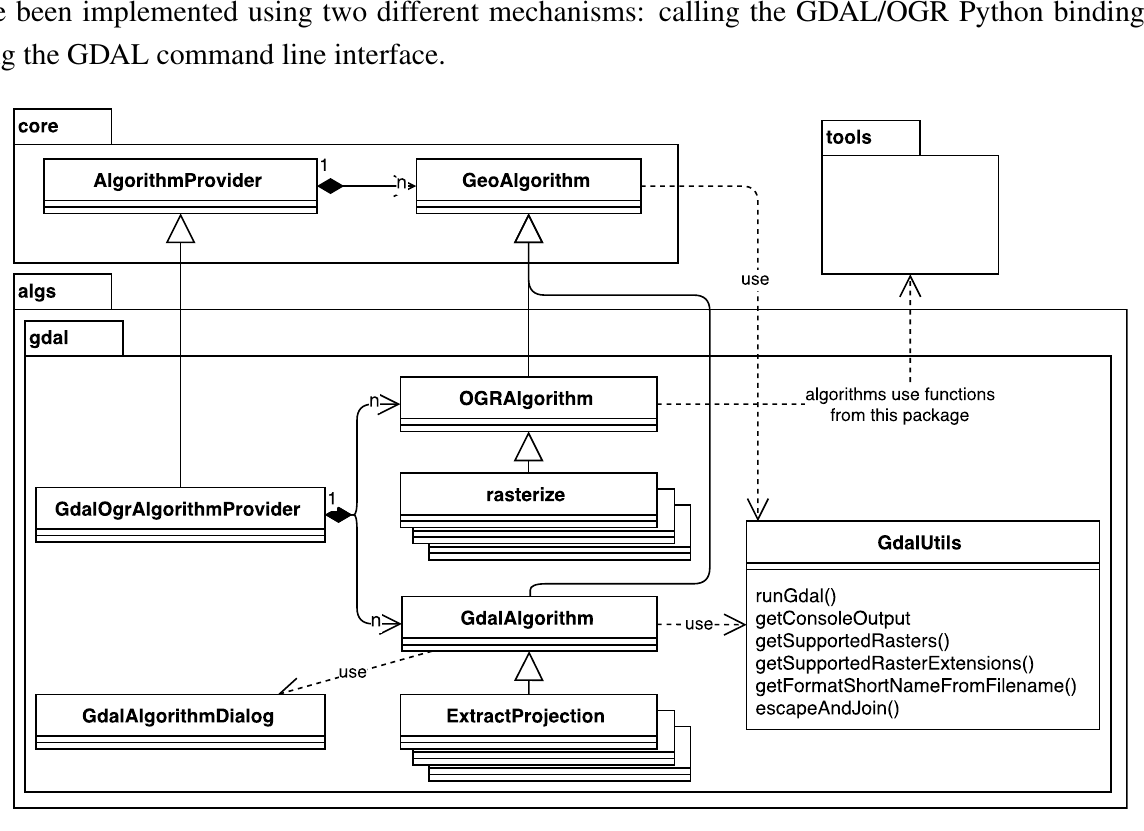
Figure 10. Class diagram of the gdal package and its connections to other